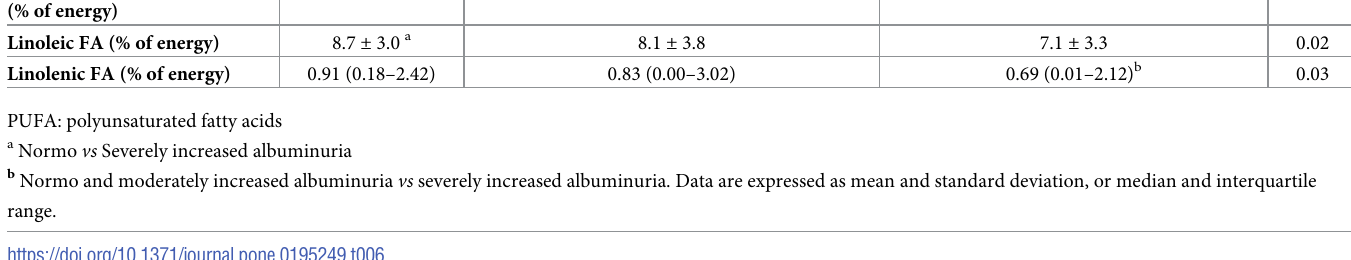
Table 6. Dietary polyunsaturated fatty acids content of type 2 diabetic patients according to the degree of albuminuria.